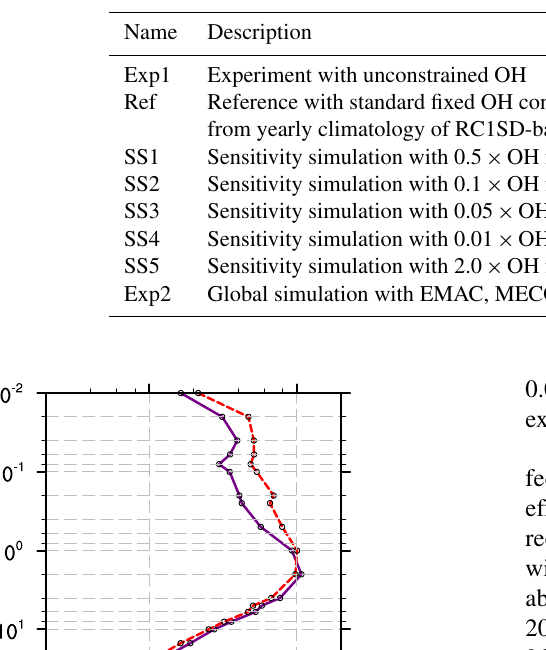
Table 2. Overview of simulations carried out in this study, including box model simulations and the sensitivity study concerning H 2 O yield dependence on OH as well as the global simulations with EMAC.